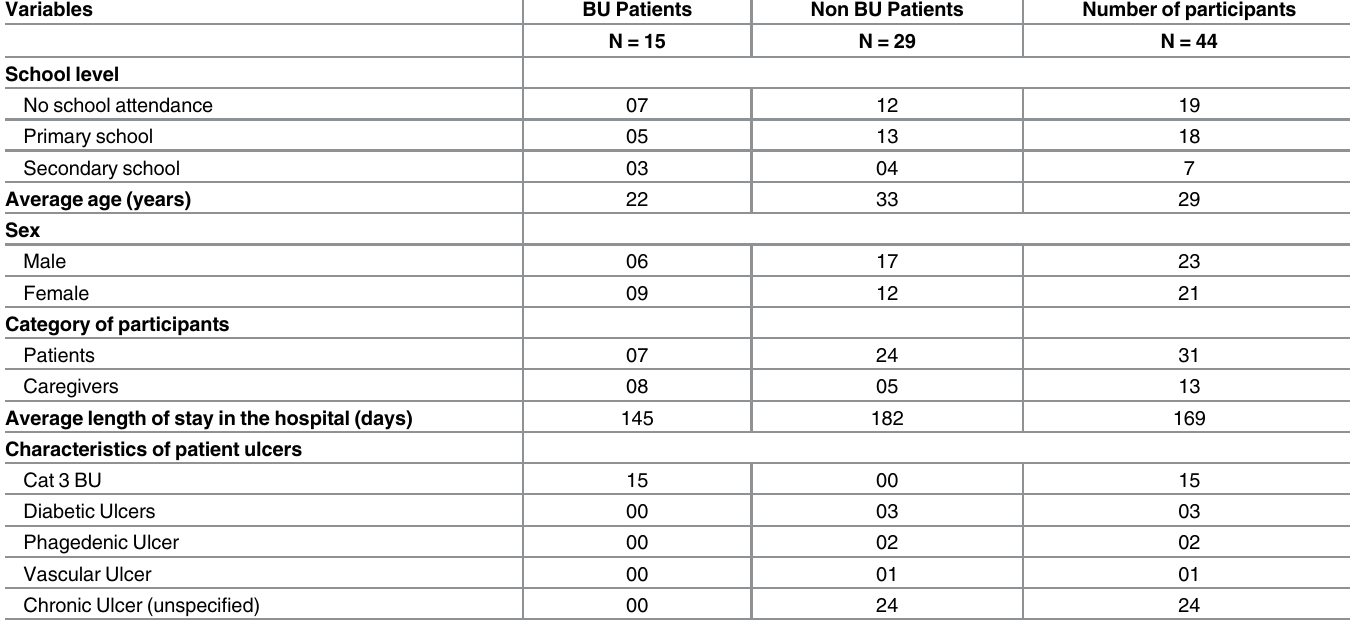
Table 3. Demographic and clinical characteristics of patients participating in final